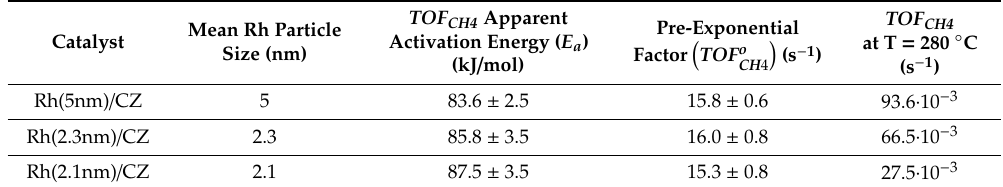
Table 4. Apparent activation energies and pre-exponential factors for CO 2 methanation reaction over Rh / CZ catalysts with di ff erent mean Rh particle